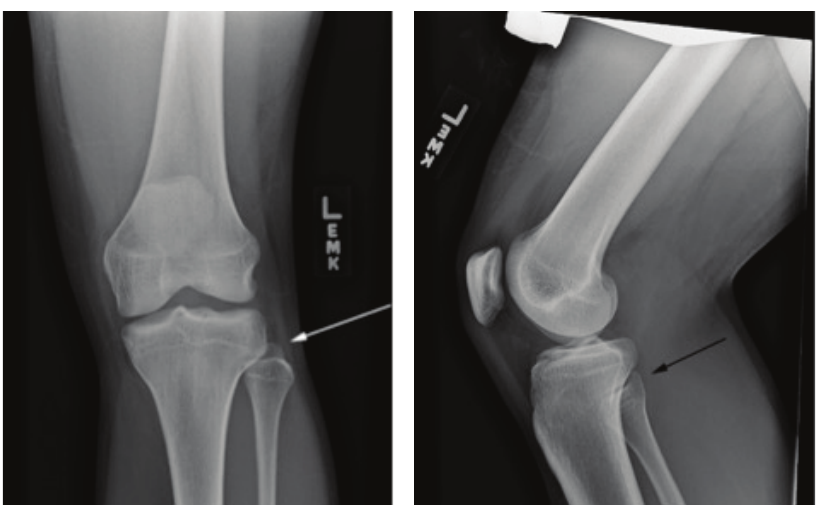
Figure 3: AP and lateral X-ray views of the left knee after reduction of the tibiofibular